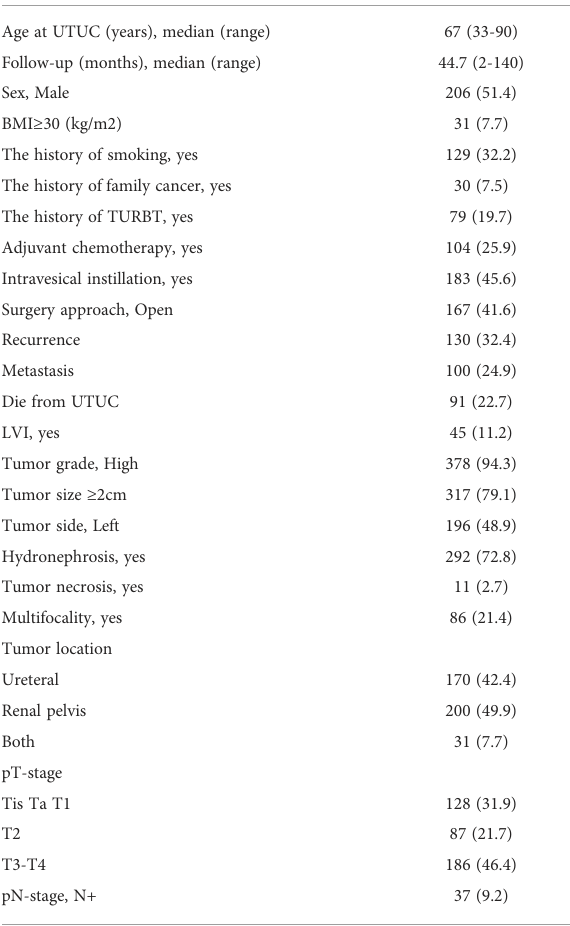
TABLE 1 Clinicopathologic features for the overall cohort of 401 patients with UTUC after RNU.